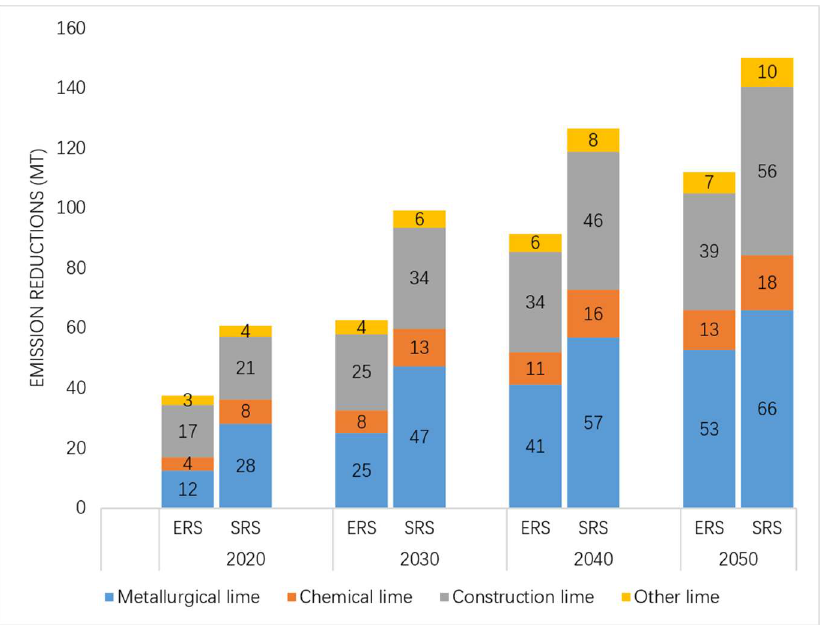
Figure 7. Emission reductions for different lime products in two emission reduction scenarios based on BAU emission levels.